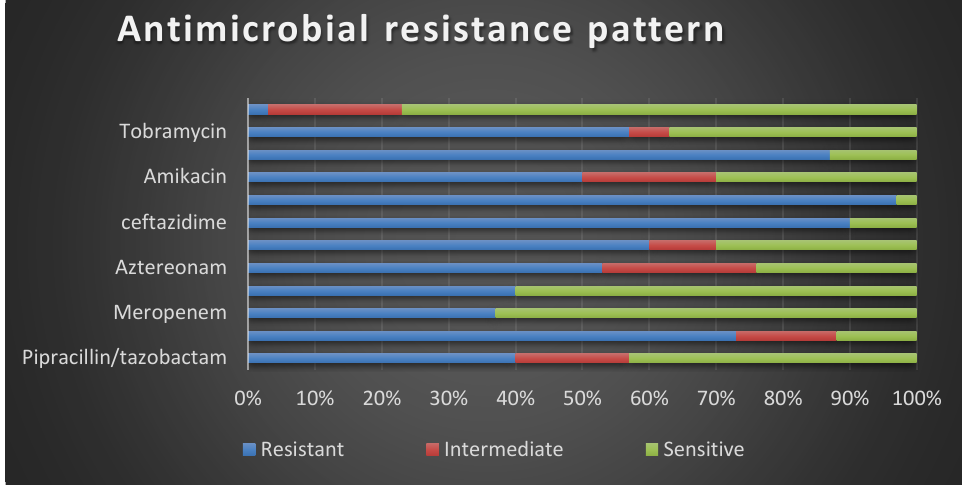
Figure 2. Susceptibility testing results of P. aeruginosa. to different antibiotics by the disc diffusion method